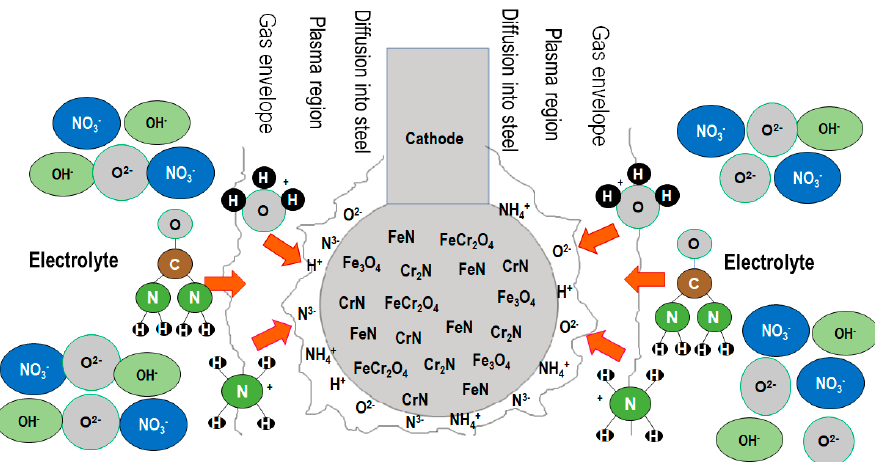
Figure 12. Schematic representation of the phenomena occurring at the electrolyte/gas enve- lope/plasma region/working electrode interfaces, during the SSONPE process.